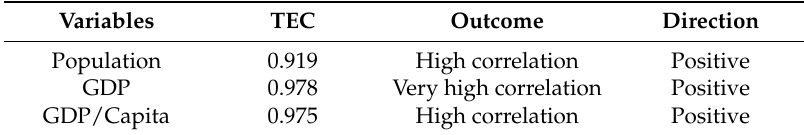
Table 5. Correlation